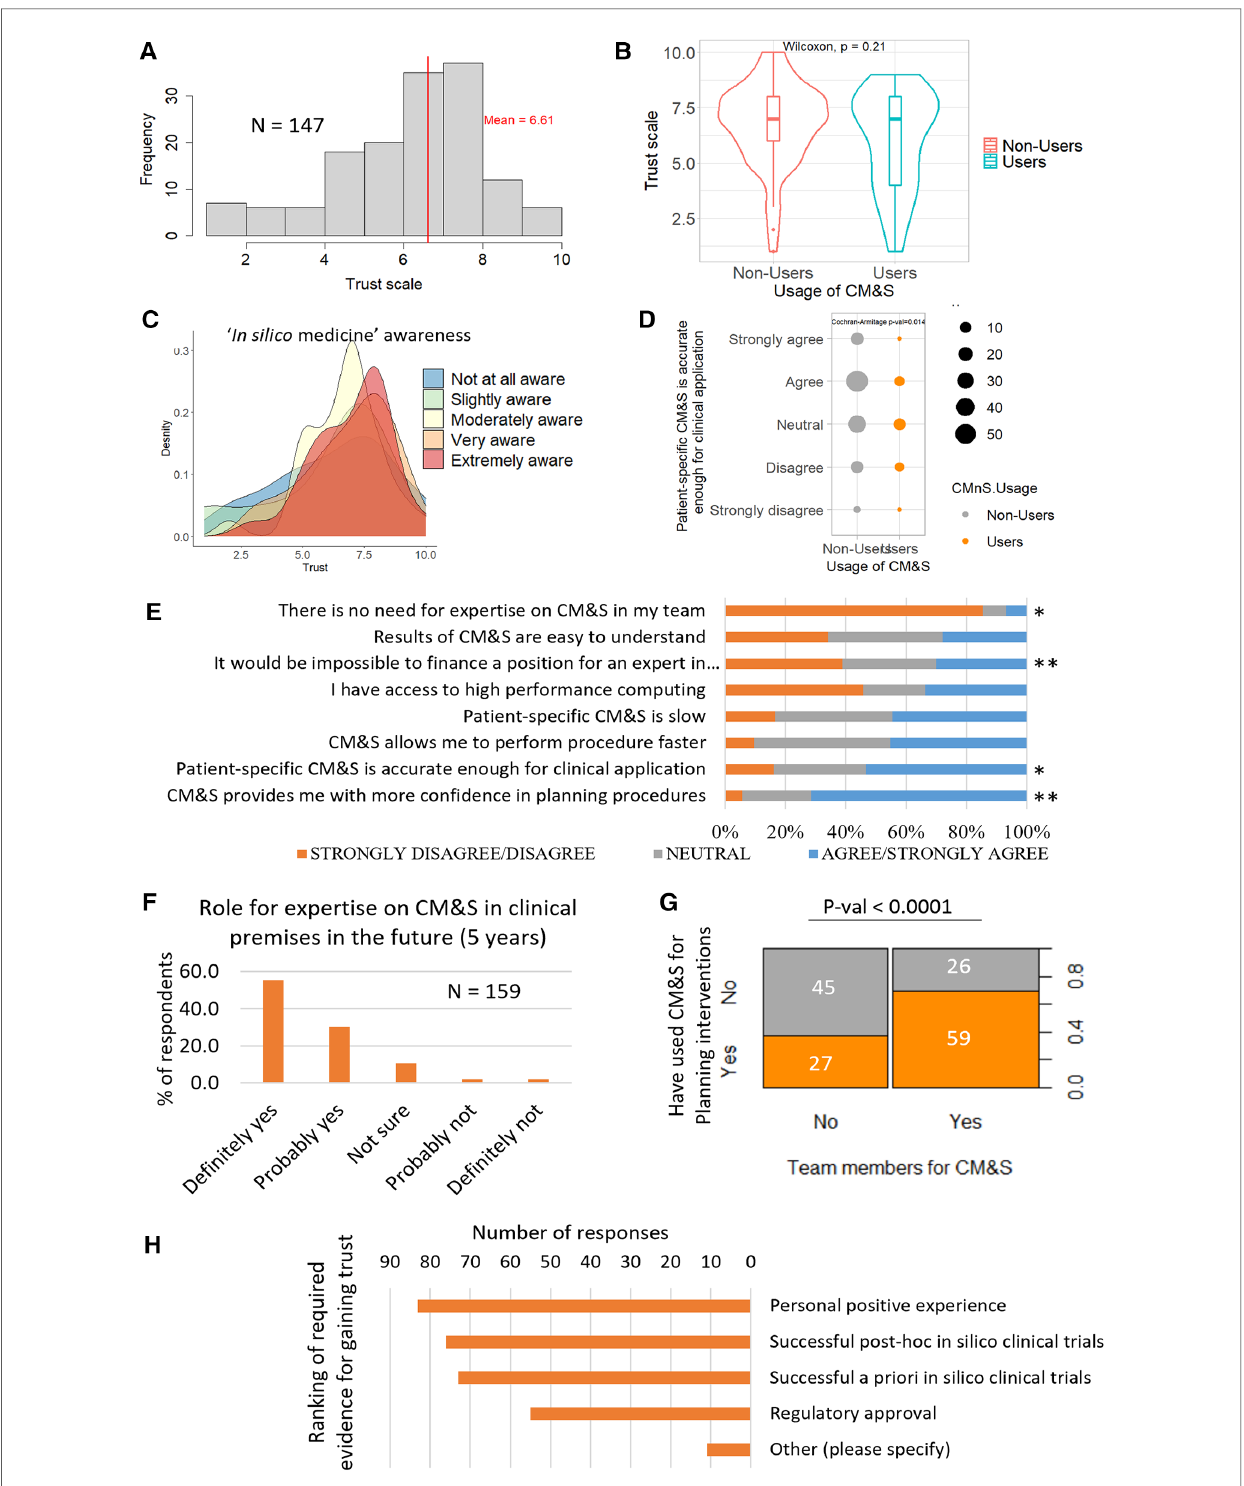
FIGURE 4 ( A ) Overall trust level distribution for in silico technologies, n =147 ( B ) Comparison of trust between CM&S users and nonusers. The grouping between user and nonuser was done according to the responses to question #4 of the survey (see Method). The non-parametric Wilcoxon test indicates that there is no signi fi cant difference of trust between users and nonusers. ( n =147) ( C ) Distribution of trust, grouped by level of awareness in “ in silico medicine ” concepts, n =147 ( D ) Comparison of agreement with statement on CM&S accuracy between users and nonusers showed that the level of agreement was dependent on the group. P -value is displayed for the Cochran-Armitage test of association to compare ordinal variable between two groups, N =156 ( E ) Level of agreement with various statements related to CM&S ( N =156 – 158 depending on the statement). The difference of answers between the user groups were evaluated with Cochrane Armitage test: * and ** indicate p -values<0.05 and <0.005 respectively. Detailed p -values in Supplementary Figure S2 . ( F ) Percentage of respondents seeing a role for expertise in CM&S in their team in the next 5 years ( G ) Association between the usage of CM&S to plan intervention and the presence of dedicated members in the team. ( H ) Type of evidence requested by clinicians to trust CM&S, ranked by number of votes (multiple choice